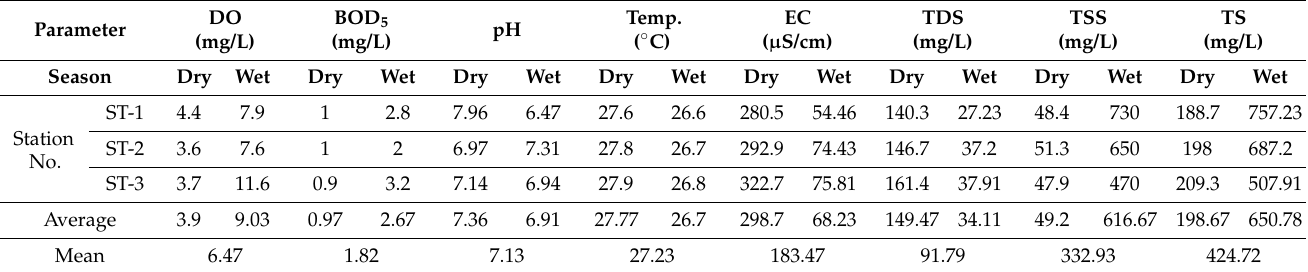
Table 3. Water quality during the dry and wet season in